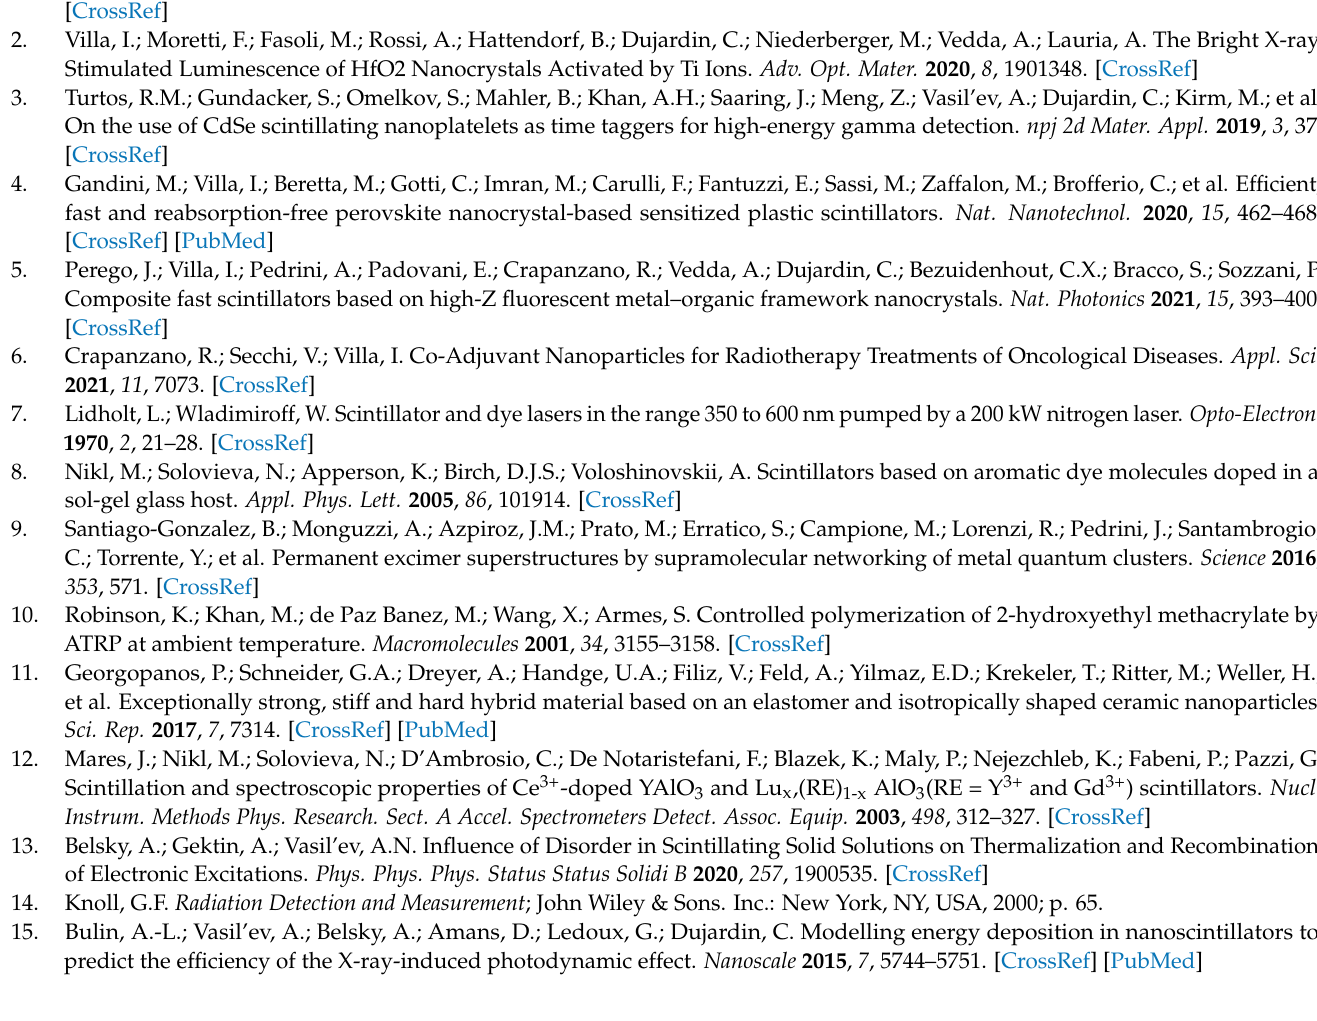
employed to analyze the time resolved luminescence, Table S2: pHEMA swelling test data. Table